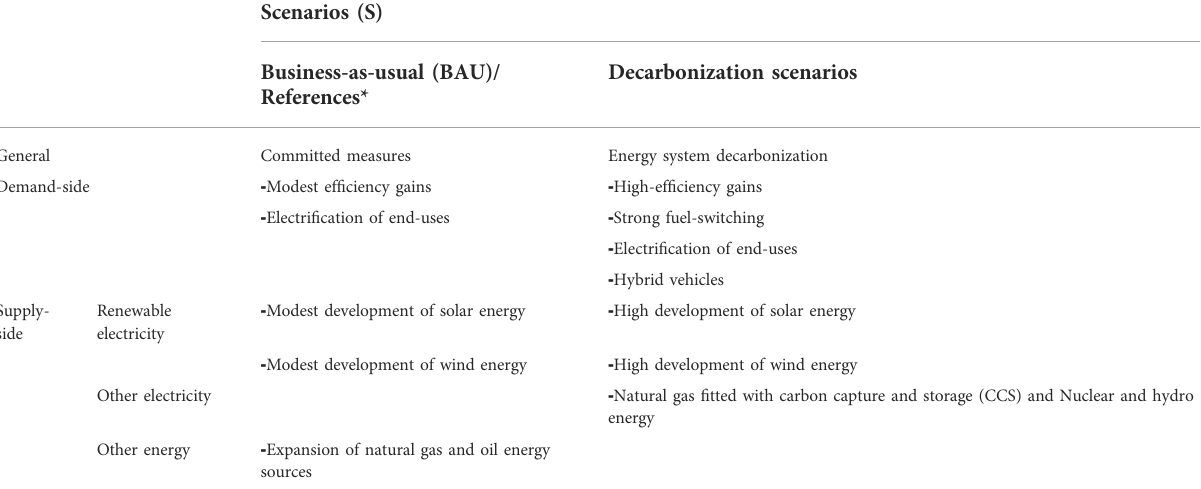
TABLE 4 Summary of the scenarios ’ characteristics in the reviewed